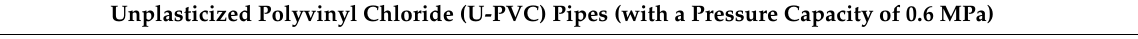
Table 3. Unit prices of commercial different